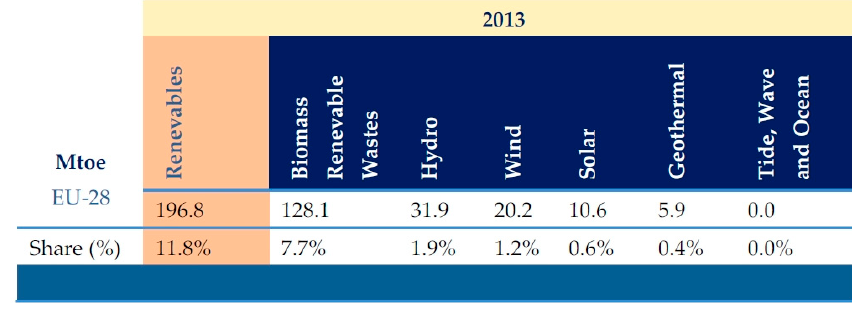
Figure 3. Use of renewable energy sources per type of energy [10,11]. Adapted from [10] with the permisison from © European Union, 2015.